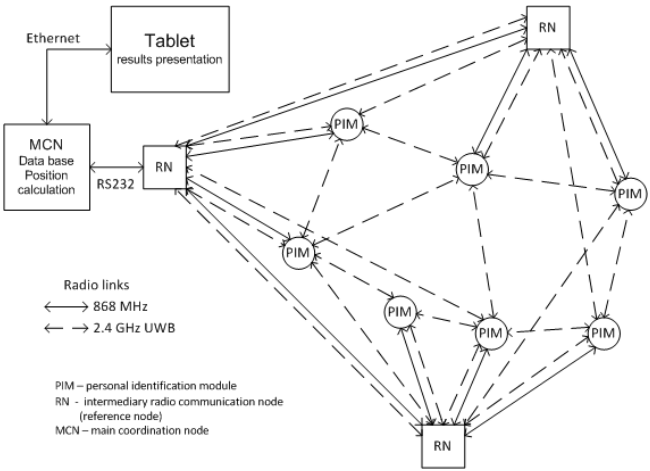
Figure 3. The scheme of the Automatic Person Localization System (SALOn) structure [3].